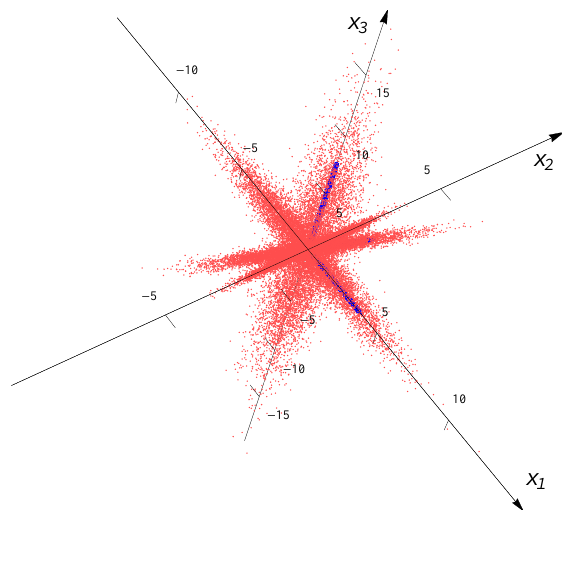
Figure 4. Sample from four overlaid Student t